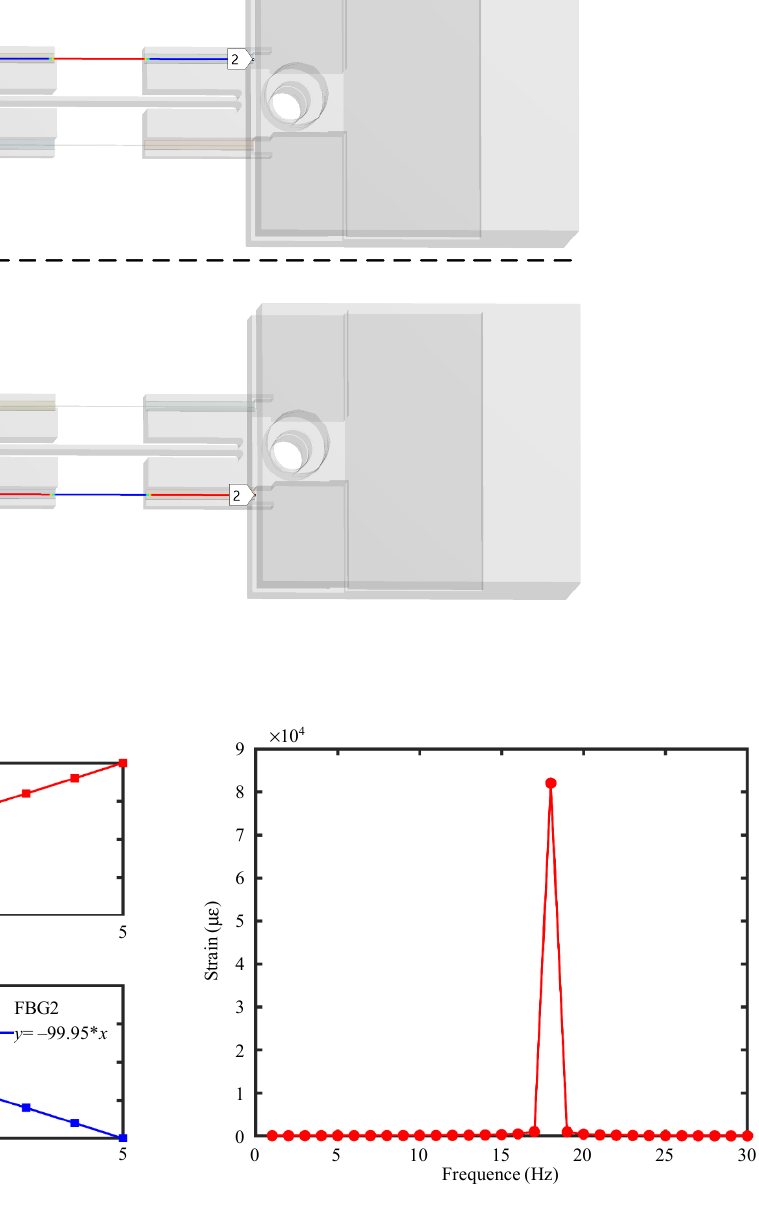
Fig. 7 Strain results of the simulation. Fig. 8 Frequency response curve of the tilt